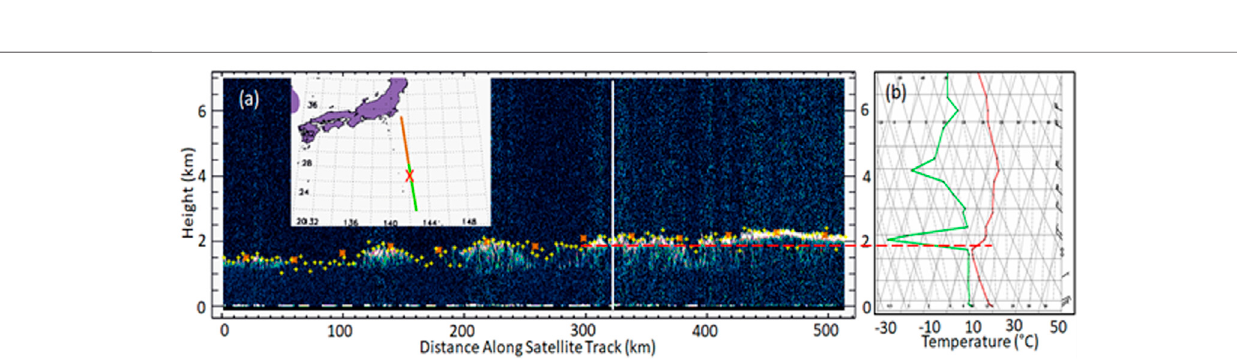
FIGURE3|(A) ICESat-2 calibratedbackscatter alongthetrackshown inthemap insetforOctober16, 2018at roughly10:59 UTCwith coarse (red asterisks) and fi ne (yellow plus signs) PBL height overlain. (B) The potential temperature (red) and relative humidity (green) from the La Paz, Mexico radiosonde at 12:00 UTC. The position of La Paz is marked on the map with a red ‘ x ” and the white vertical line in (A) marks the closest approach of ICESat-2 to La Paz.